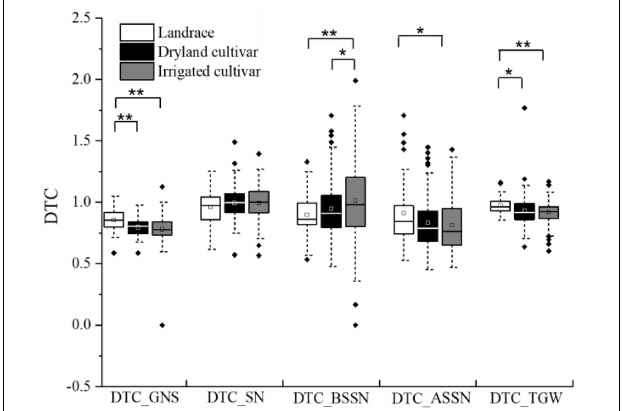
FIGURE 1 | DTC value of related traits in dryland, irrigated cultivars, and landraces. * and ** represent significance level of P < 0.05 and P < 0.01.